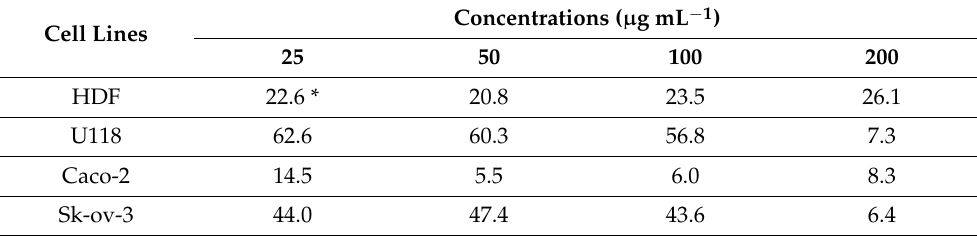
Table 5. Percent (%) viability rates of cell lines after interaction with varying concentration ranges of